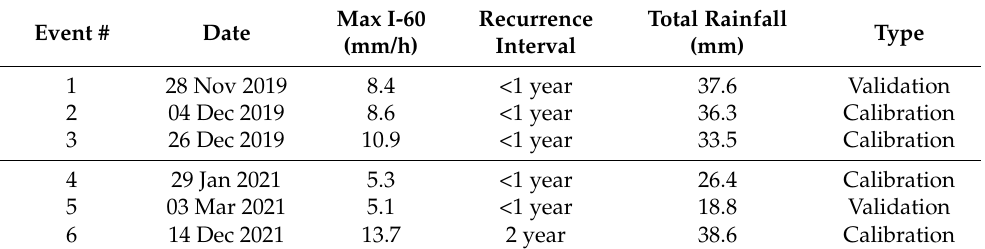
Table 3. Storm events and characteristics (maximum 60 min rainfall intensity (Max I-60), recurrence interval, and total rainfall) selected for calibration and validation of pre-vegetation restoration (2019) and post-vegetation restoration (2021)